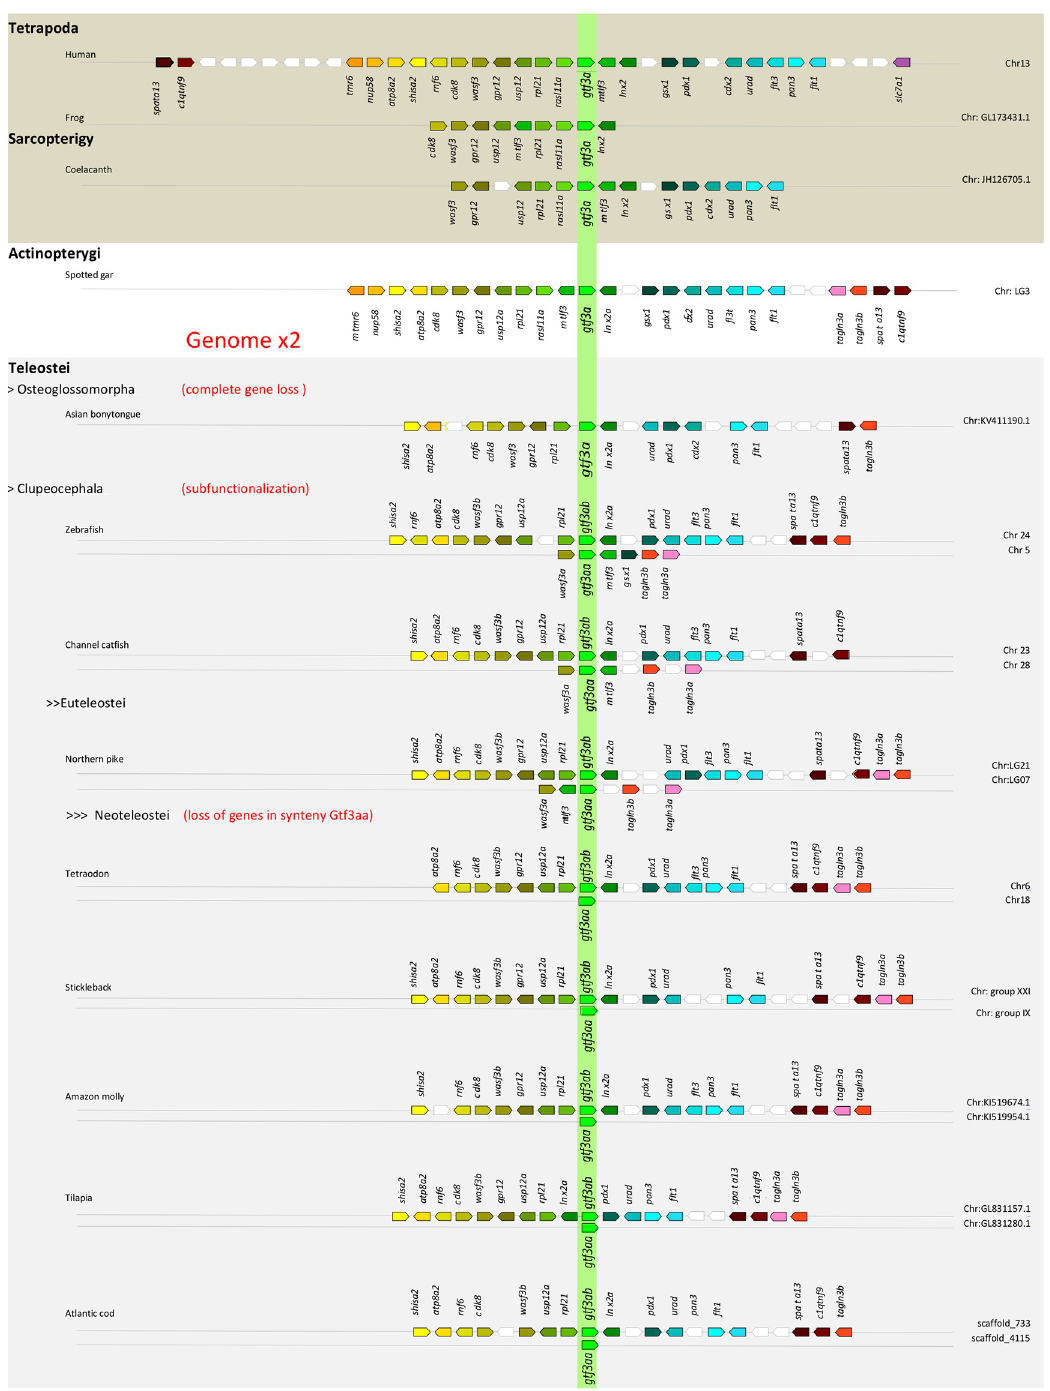
Fig 2. Conserved genomic synteny of vertebrate gtf3a genes. Genomic synteny maps comparing localisation gtf3a and neighbouring genes in the genomes of tetrapods (human and frog), a basal sarcopterygian (coelacanth), a non-teleost actinopterygian (spotted gar) and different teleost species (Asian bonytongue, zebrafish, channel catfish, northern pike, tetraodon, stickleback, amazon molly, tilapia and Atlantic cod). In teleosts, with the exception of Asian bonytongue, two gtf3a paralogs exits ( gtf3aa and gtf3ab ) and the neighbouring genes are shown in comparison to the genes surrounding human gtf3a . Orthologs for each gene are represented with the same colour and displayed in the order and direction in which they are placed in each chromosome or scaffold as indicated in the right side of the Fig (detailed genomic locations for each gene are given in S1 Table).